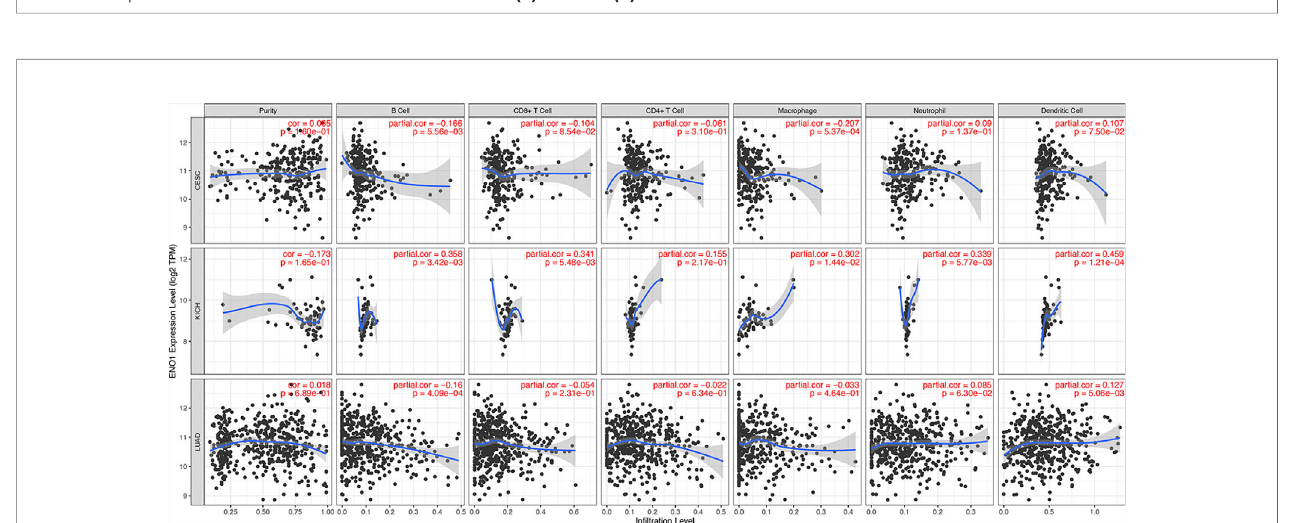
FIGURE 7 | Kaplan – Meier survival curves of the prognostic signi fi cance of altered and unaltered of ENO1 using the cBio Portal. Survival curves comparing survival outcomes of patients with altered and unaltered of ENO1 for OS (A) and DFS (B) with 95% con fi dence